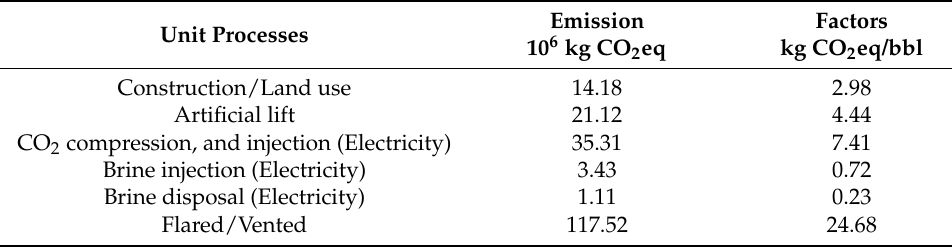
Table 6. Mass Emissions and Factors for EOR units (Task 1).